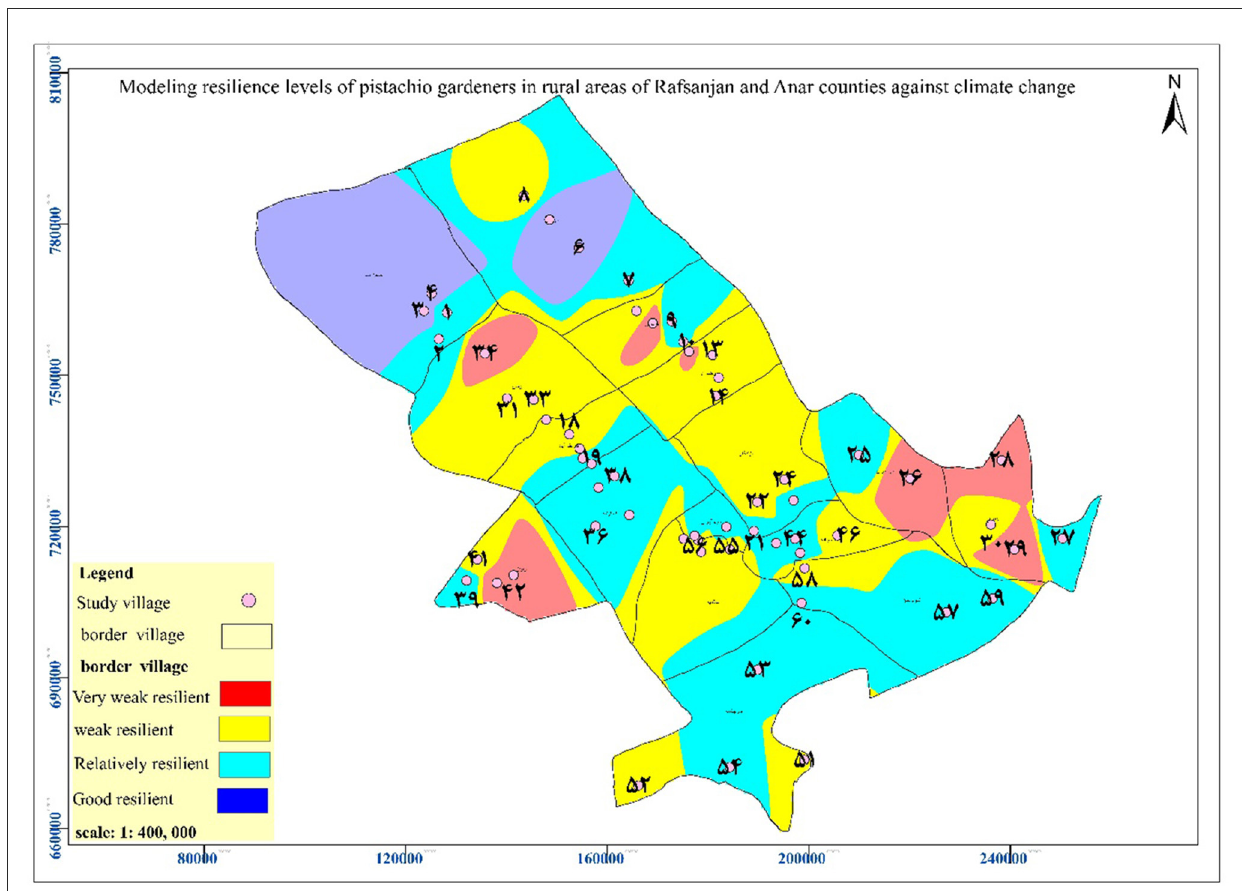
FIGURE3 Modeling the levels of resilience of pistachio farmers in rural areas of Rafsanjan and Anar counties against climate change (drawing by